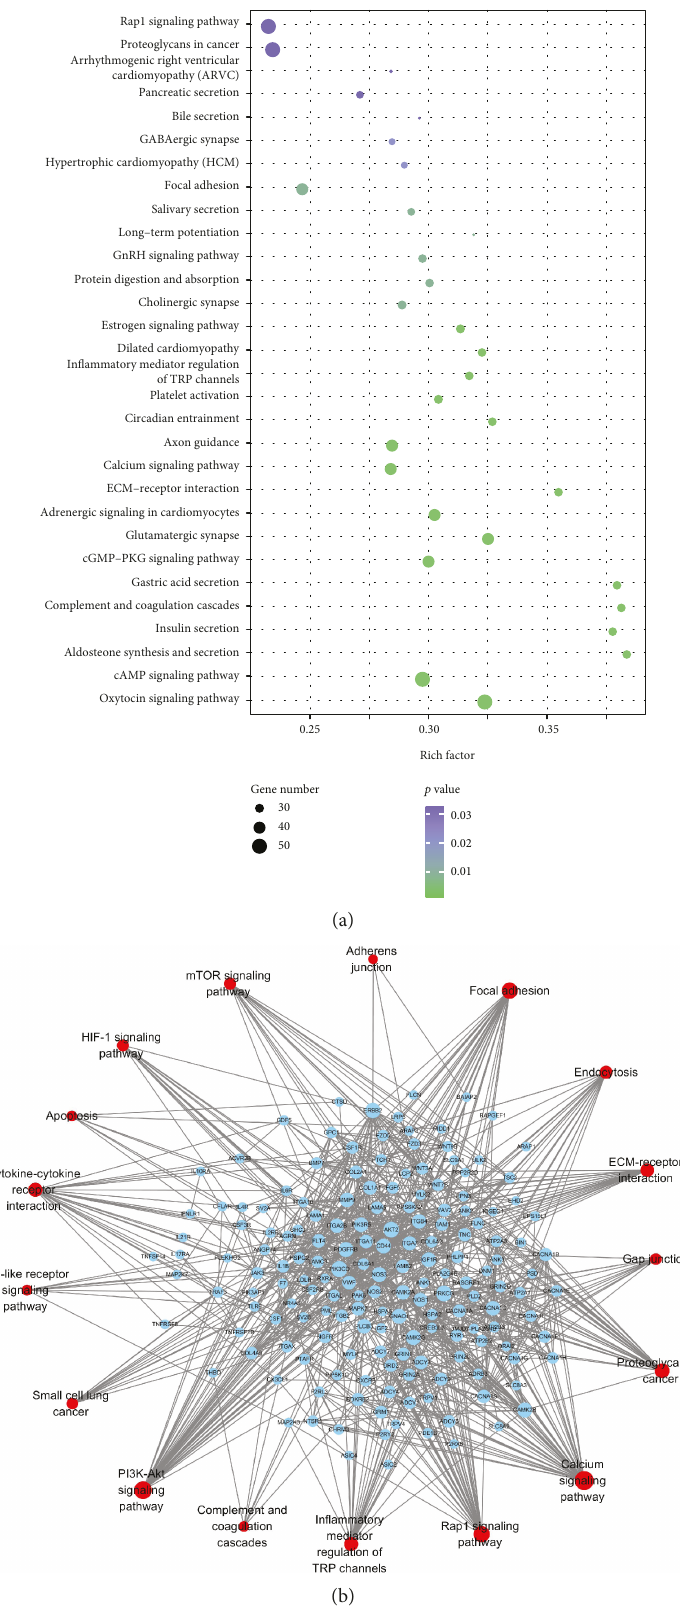
Figure 3: The KEGG pathway analysis and the PPI network of DEGs. (a) The top 20 most signi fi cant KEGG pathway terms. (b) The PPI network of overexpressed